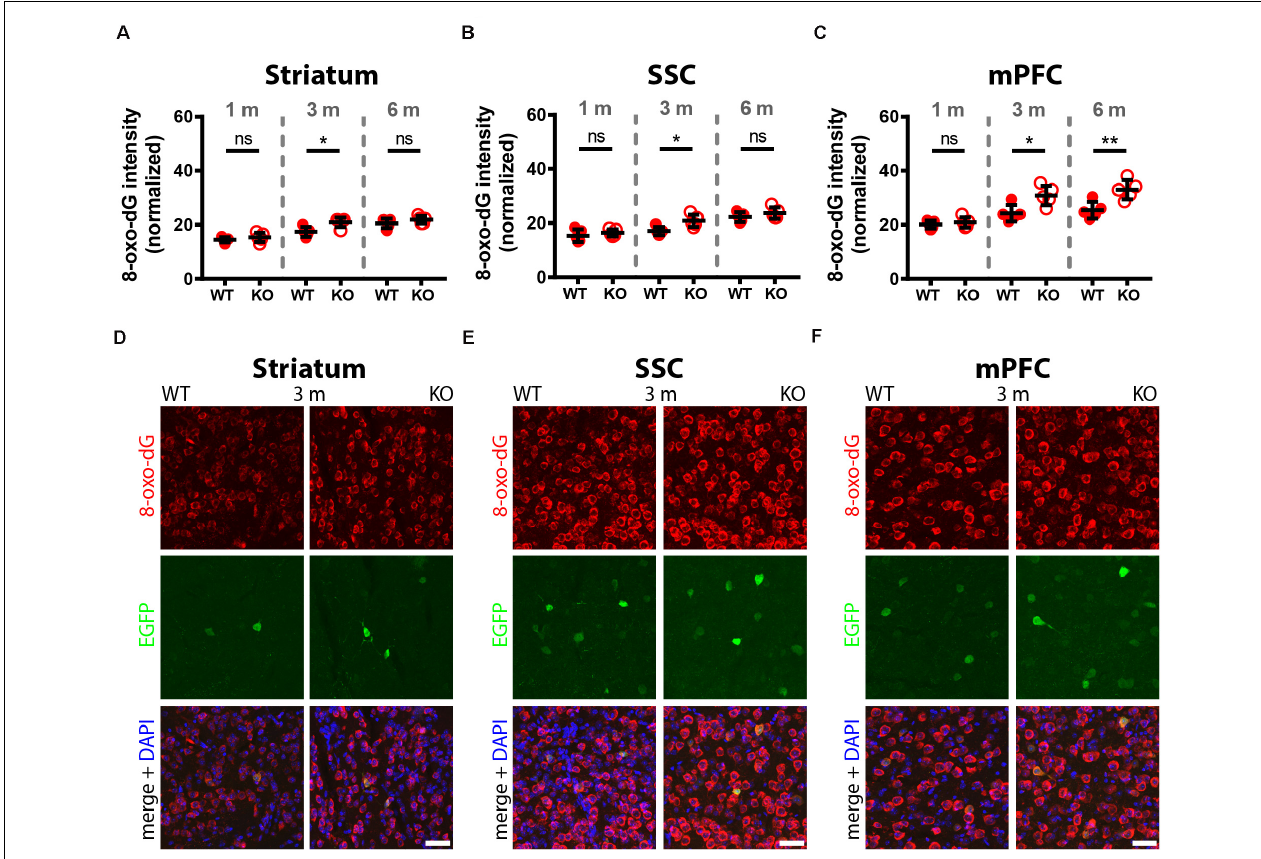
FIGURE 3 | Comparison of 8-oxo-dG signal intensity in striatum, SSC and mPFC of 1, 3, and 6-months old WT and KO mice. Normalized 8-oxo-dG fluorescence signal intensities (a.u.) analyzed in striatum (A) , SSC (B) and mPFC (C) are shown. Representative images with immunofluorescence labeling for 8-oxo-dG (red), EGFP (green) and merged images with DAPI (blue) are shown in striatum (D) , SSC (E), and mPFC (F) of 3-months old WT (left panels) and KO (right panels) mice. Scale bars: 40 µ m. Each dot in the graphs represents the average obtained in 1 animal (5 mice per genotype) and 10–15 cells per animal resulting in > 50 cells per brain region (striatum, SSC, mPFC) and genotype. ns not significant; * p < 0.05; ** p < 0.01. Values are reported in Table 1